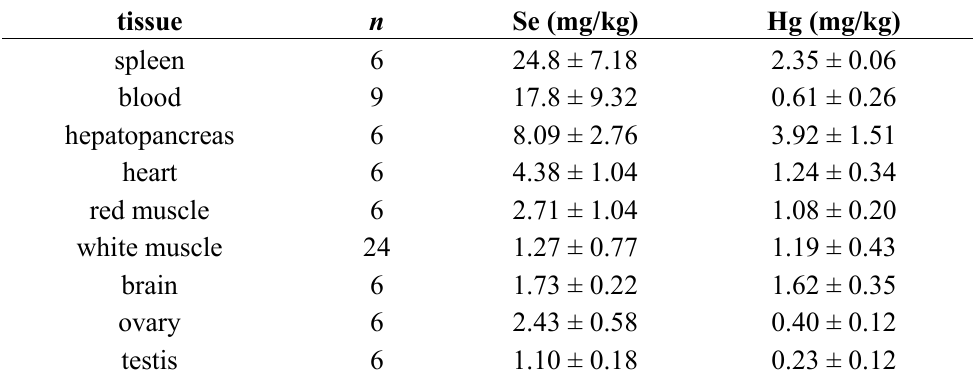
Table 3. Distribution of selenium and mercury in the various tissues of alfonsino.